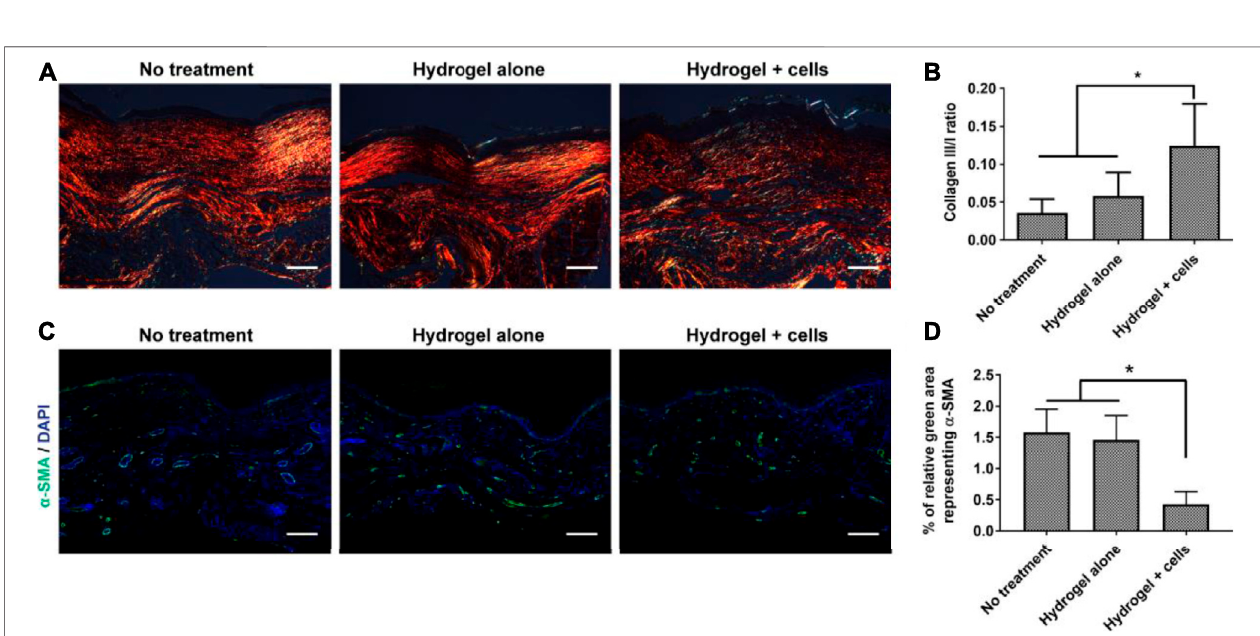
FIGURE 8 | (A) S-Ag coordination bonds between thiolated bovine serum albumin (BSA-SH), thiolated polypeptide (KK-SH), and Ag + to form hydrogel (Cheng et al., 2020). Images were adapted with permission from Cheng et al. (2020). Copyright 2020, John Wiley and Sons. (B) With copper ion as peroxidase-like agent, hydrogel crosslinkedwithcopper ionsigni fi cantlydeceased survivalratesofDR- S.aureus (i) andDR- E.coli (ii) (Qiuet al.,2020).Images wereadapted withpermission from Qiu et al. (2020). Copyright 2020, Springer Nature.